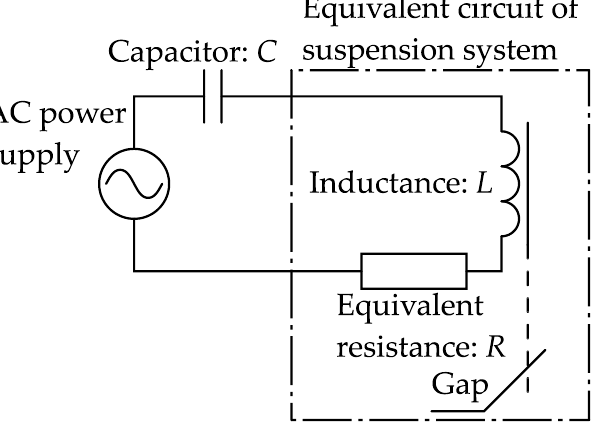
Figure 2. Equivalent circuit diagram of AC magnetic suspension system. The AC power supply generates a sinusoidal voltage with a constant frequency and a constant amplitude. The dash–dot rectangle represents an equivalent circuit of suspension system. The inductance varies with the gap between the electromagnet and the magnetic target.